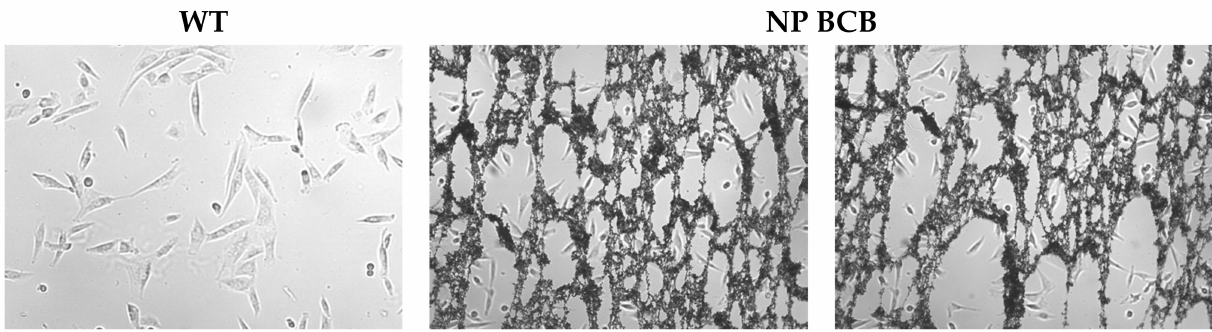
Figure 7. Photographs of SkM cells either of wildtype (WT) or incubated with nanoparticles loaded with BCB (NP-BCB).